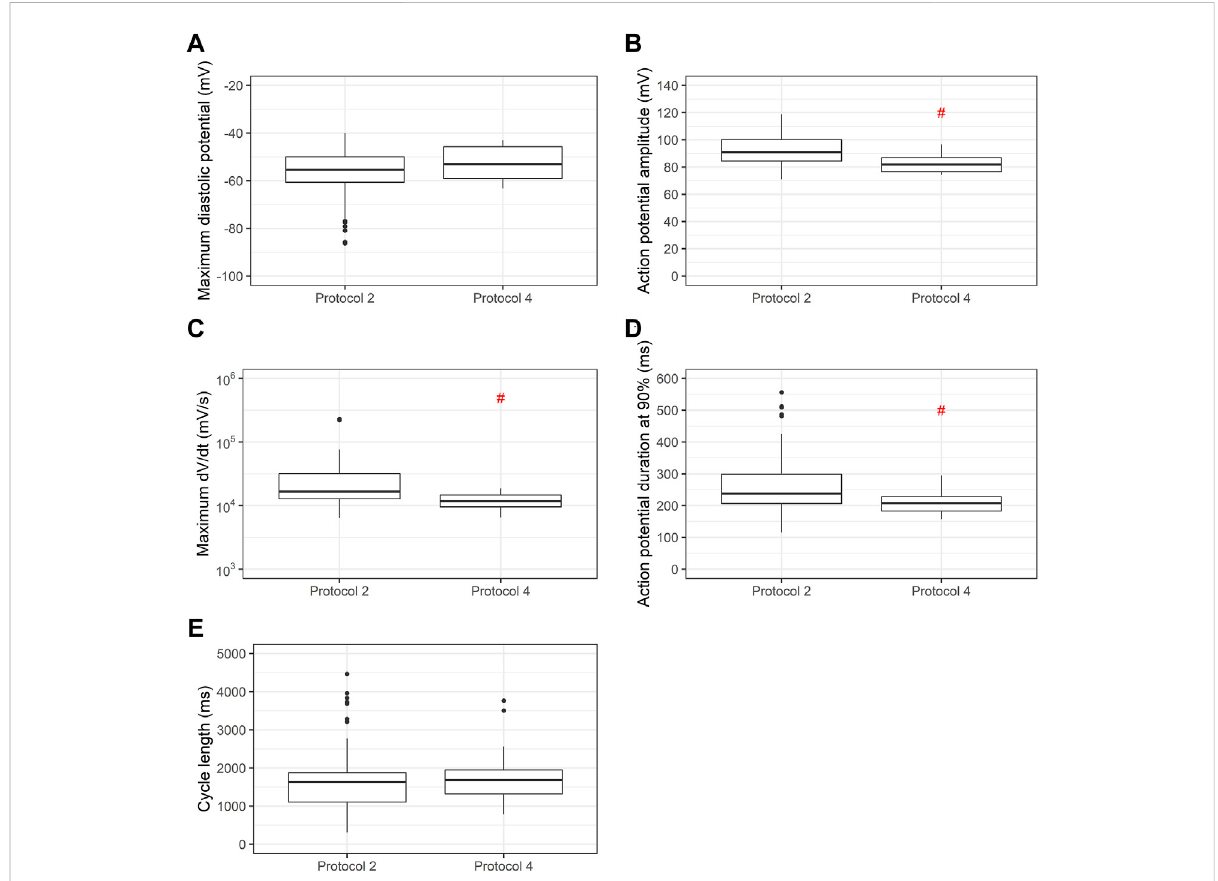
Comparison of action potential variables using two differentiation protocols in the same cell line. Box plots of (A) maximum diastolic potentials (MDP), (B) action potential amplitudes (APA), (C) maximum dV/dt (dV/dt max), (D) action potential duration at 90% repolarization (APD90) and (E) cycle length for cell line 2 using Lian ’ s and a commercial protocol. Red # indicates p < 0.05 using Student ’ s t-test.